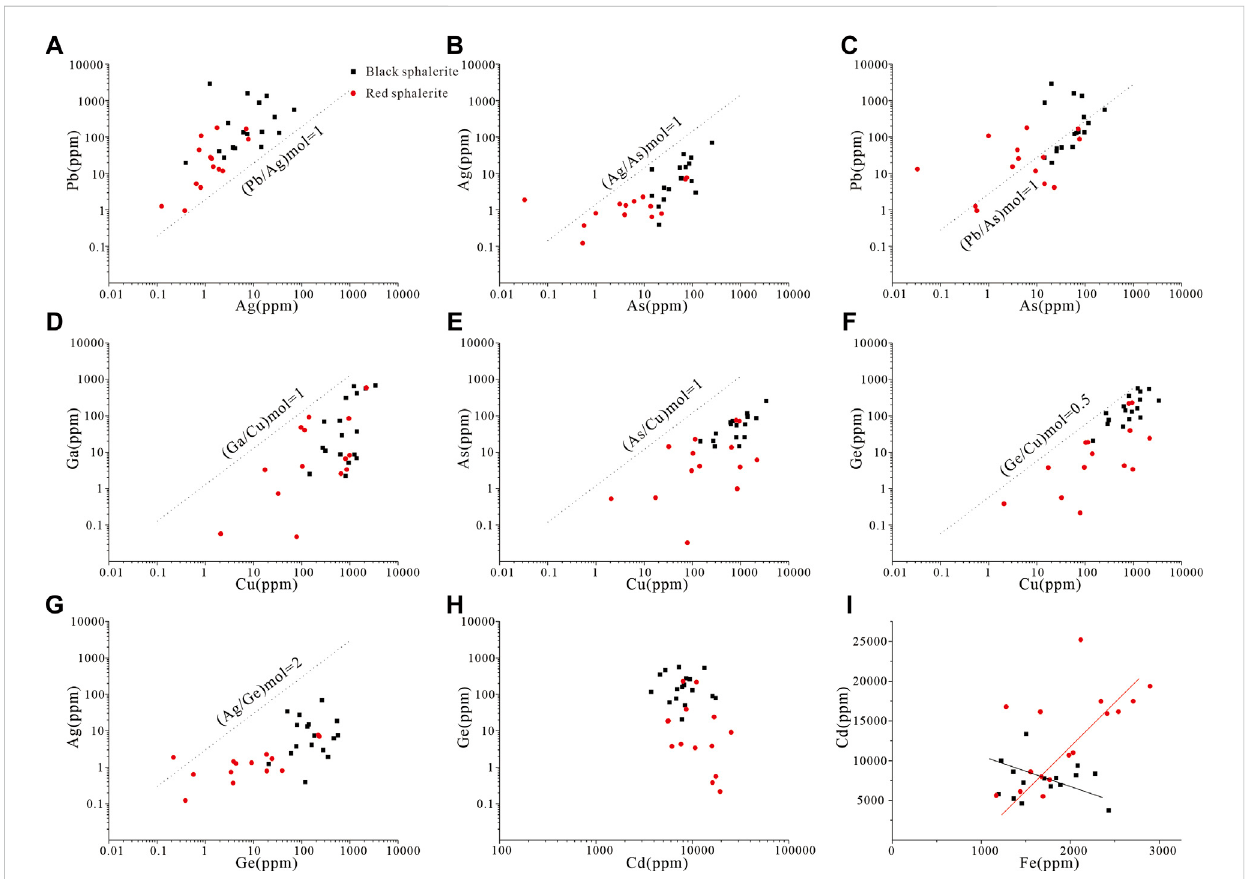
FIGURE 8 Binary plots illustrating the relationship of trace elements in sphalerite from the Fuli Pb-Zn